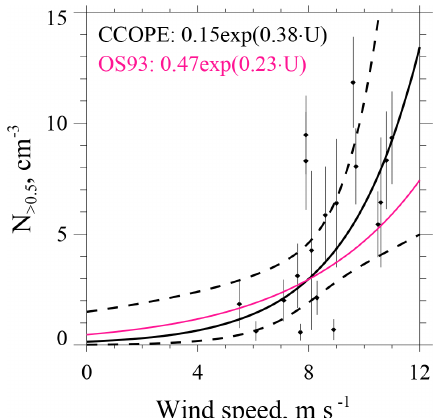
Figure 9. Averaged values of N > 0 . 5 ( ± 1 standard deviation) vs. HYSPLIT-derived averaged U s for the 18 sea surface trajectories that arrived at the Arauco site between 29 May and 28 June 2015. The black curve is the fit of the CCOPE data; dashed curves above and below the black curves are 95% confidence intervals (Romano, 1977; his Eq. 4.2.3.f). The pink curve is the fit reported by O’Dowd and Smith (1993) for 0.38µm <D < 0 .